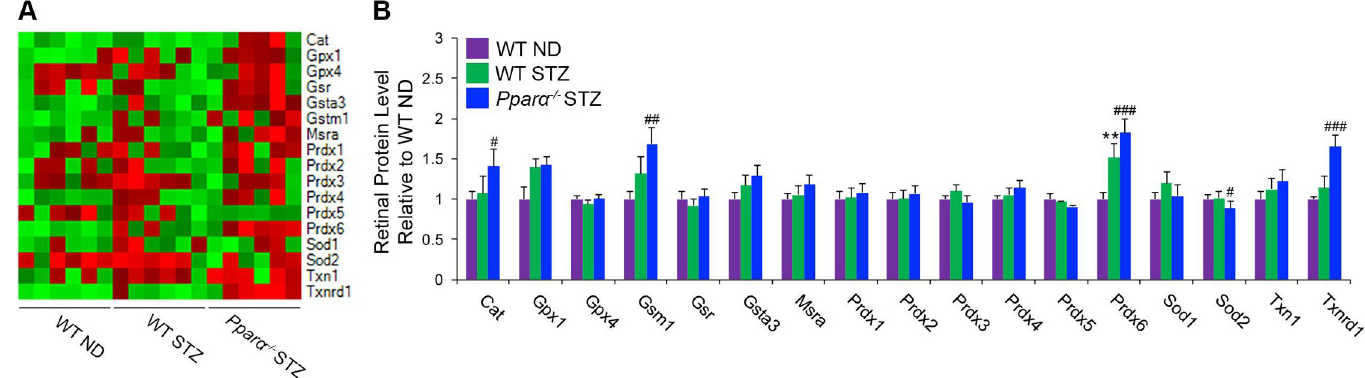
Fig 7. Increased oxidative stress markers in Ppar α -/- diabetic retinas. (A) Heatmap representation of quantitative proteomic analysis of wild-type (WT) non-diabetic (ND) retinas, WT streptozotocin (STZ)-induced diabetic retinas and Ppar α -/- diabetic retinas at 28 weeks diabetic. (B) Relative retinal protein levels of antioxidant enzymes Gsm1, Prdx6 and Txnrd1 were increased in WT diabetic mice and further increased in Ppar α -/- diabetic retinas. Cat was increased in Ppar α -/- diabetic retinas relative to WT diabetic retinas. (n = 6 mice/group). � p � 0.05; �� p � 0.01relative to WT ND group. #p � 0.05; ###p � 0.001 relative to WT diabetic group. One-way ANOVA with Tukey’s post-hoc